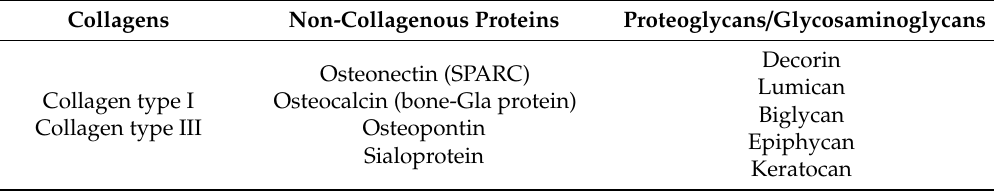
Table 1. The main components of bone organic extracellular matrix (ECM)